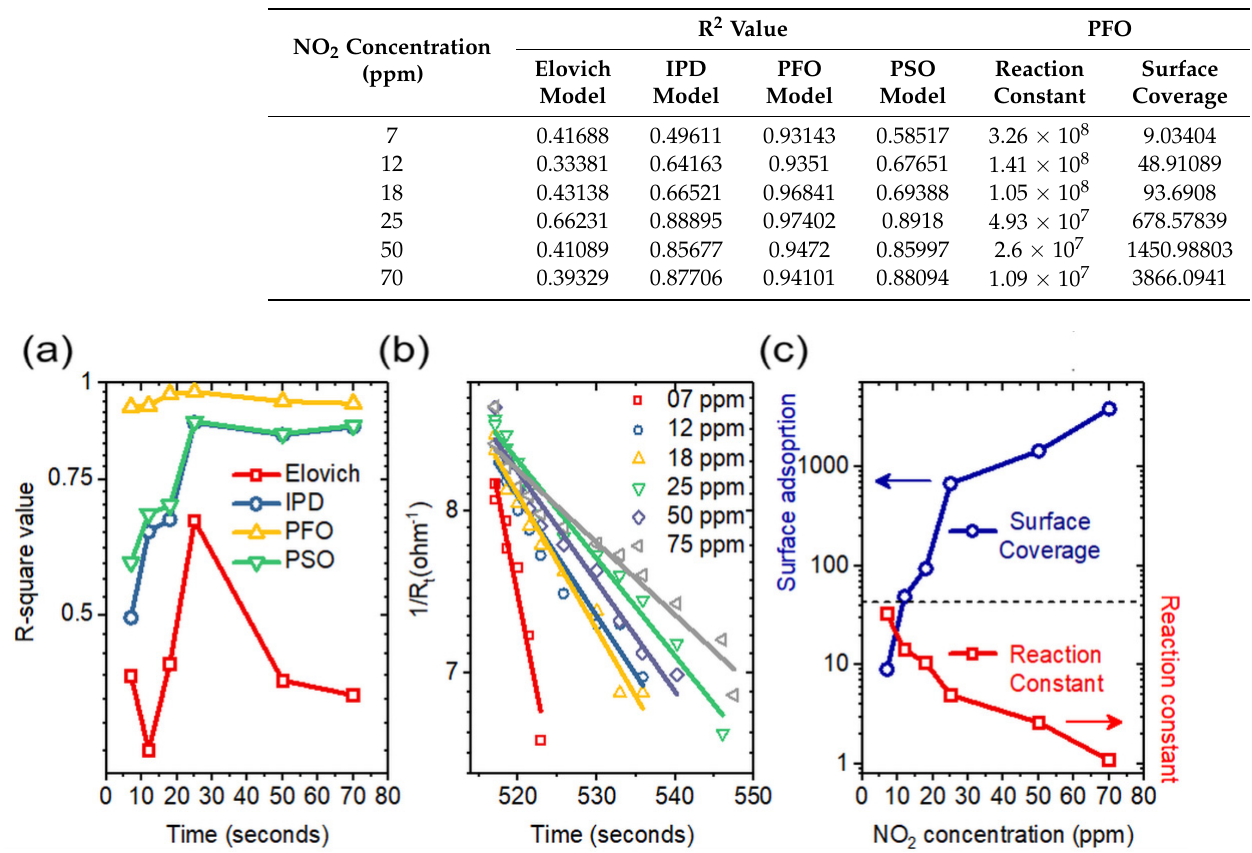
Table 1. The R 2 values obtained with the help of the Elovich model, IPD, PFO, and PSO model. The table also includes the adsorption constants (reaction rate constant and surface coverage) obtained via the PFO model.